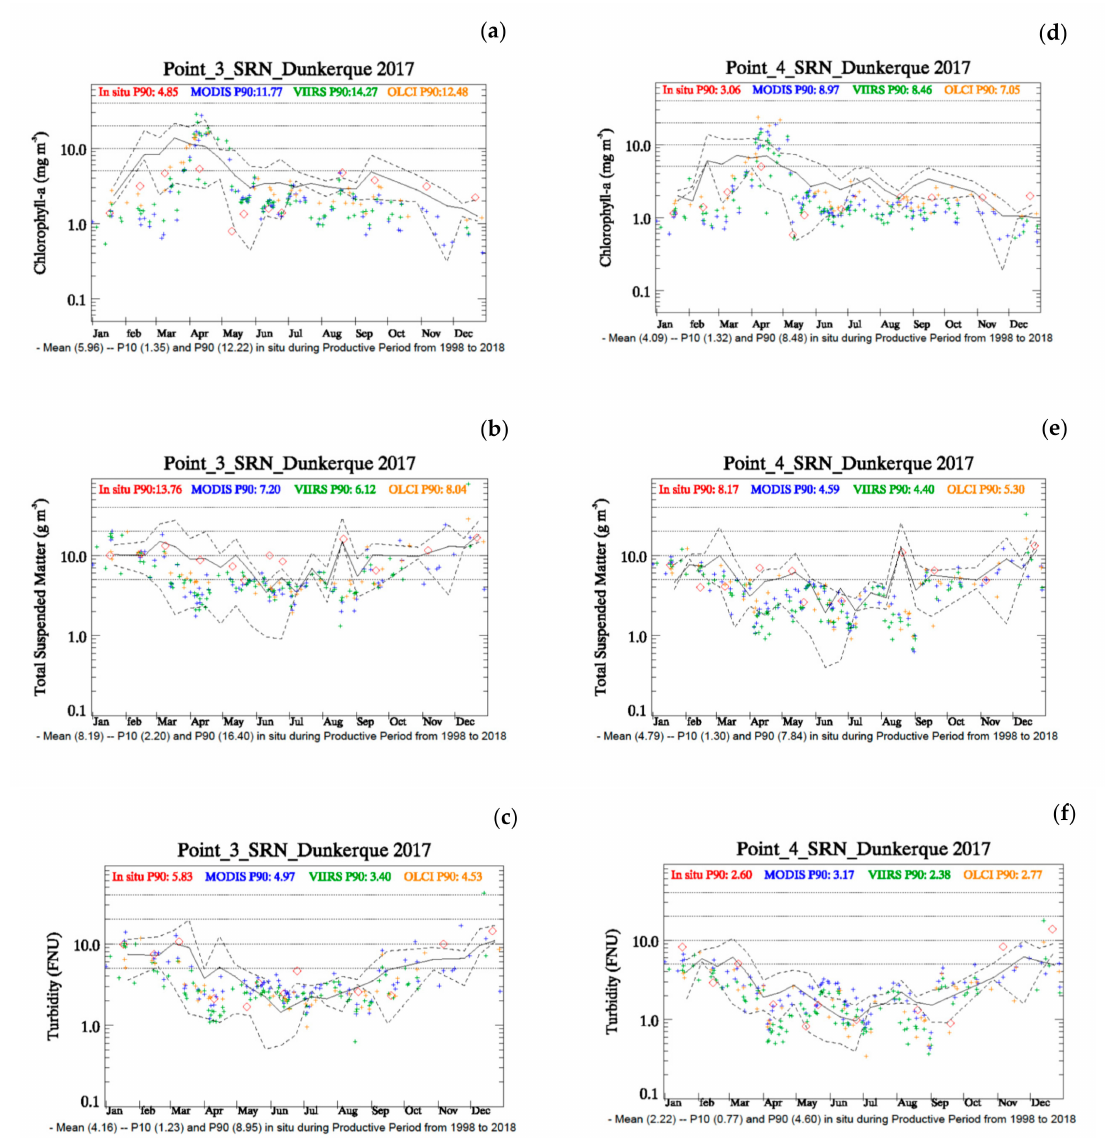
Figure 3. Chl- a ( a , d ), TSM ( b , e ) and Turbidity ( c , f ) in the southern North-Sea. In situ and satellite percentiles of year 2017 are indicated in the upper part of the graphs; the in situ historical mean, P10 and P90, calculated over the productive period, are indicated under the time